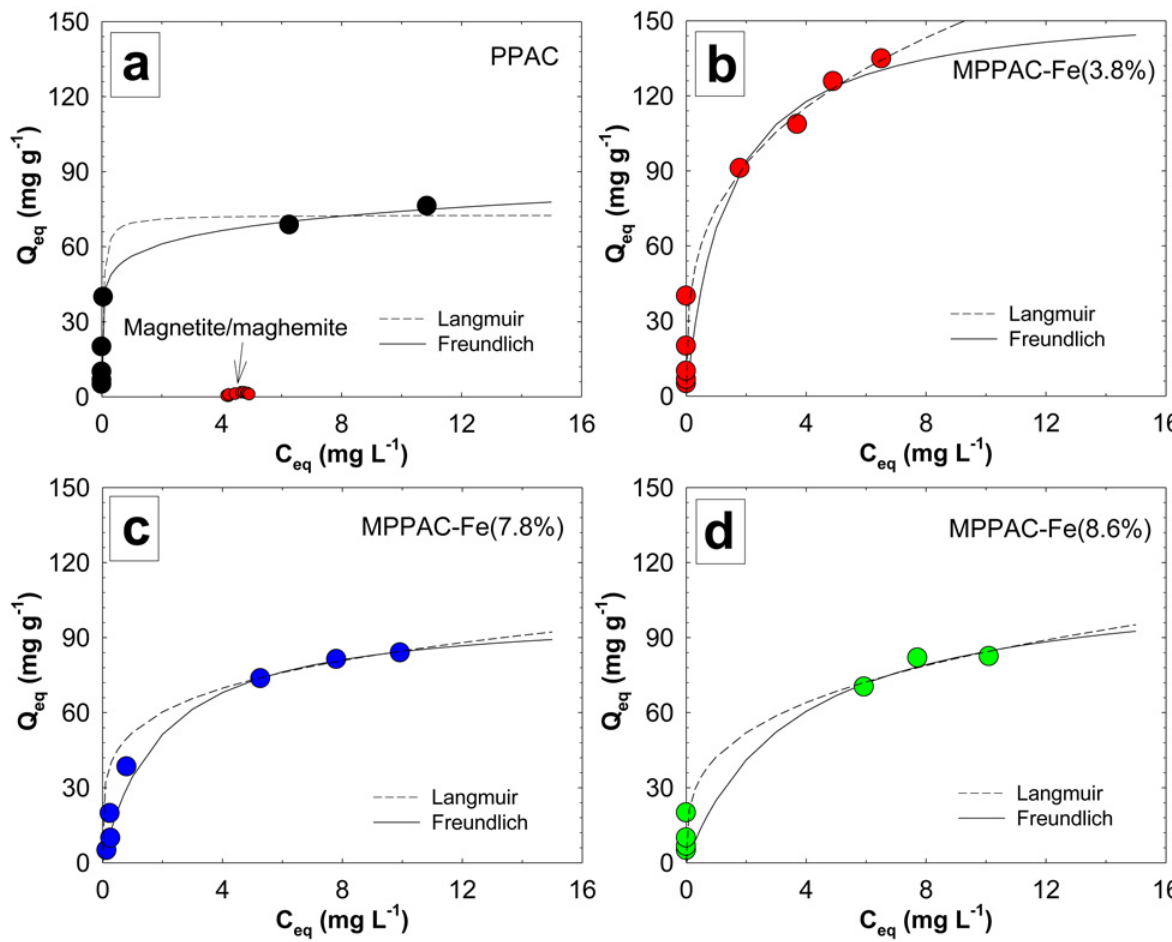
Fig 5. (a-d) Adsorption isotherms of IBP uptake by media at pH 7.0 and 0.1 M ionic strength, Langmuir (long dashed line) and Freundlich models (solid line).